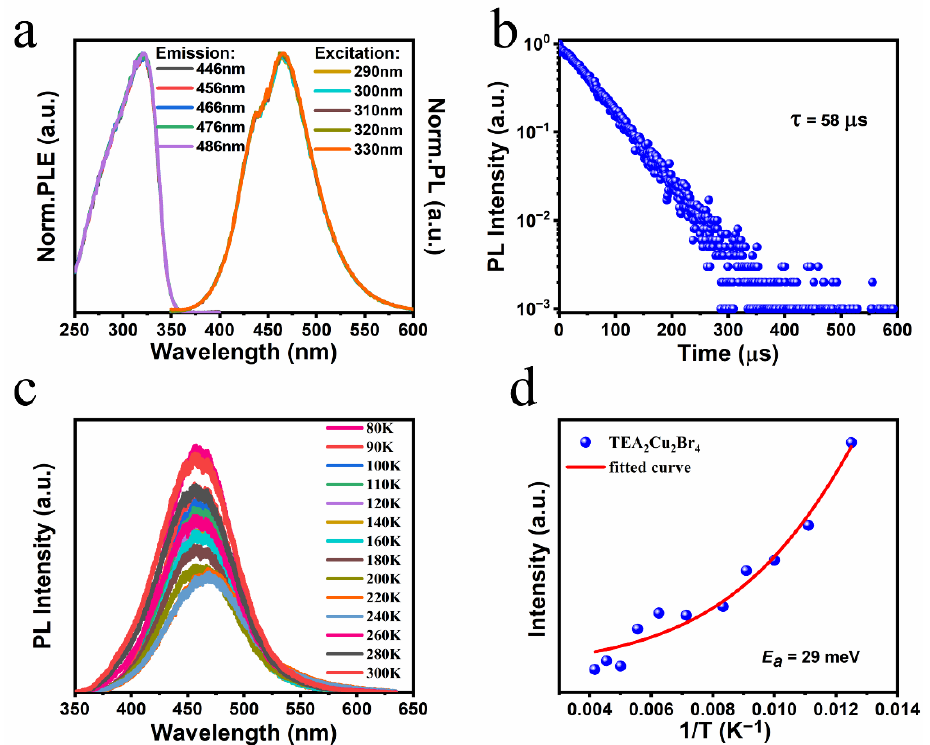
Figure 3. PL performance of TEA 2 Cu 2 Br 4 crystal. ( a ) Normalized PL and PLE spectra of TEA 2 Cu 2 Br 4 . ( b ) Time-resolved PL decay curve of TEA 2 Cu 2 Br 4 at room temperature. ( c ) Temperature-dependent PL spectra of TEA 2 Cu 2 Br 4 . ( d ) Integrated PL intensities vs. temperature plots of TEA 2 Cu 2 Br 4 crystal. The plots were fitted with Arrhenius function, and the obtained activation energy is ~28 ± 1 meV.